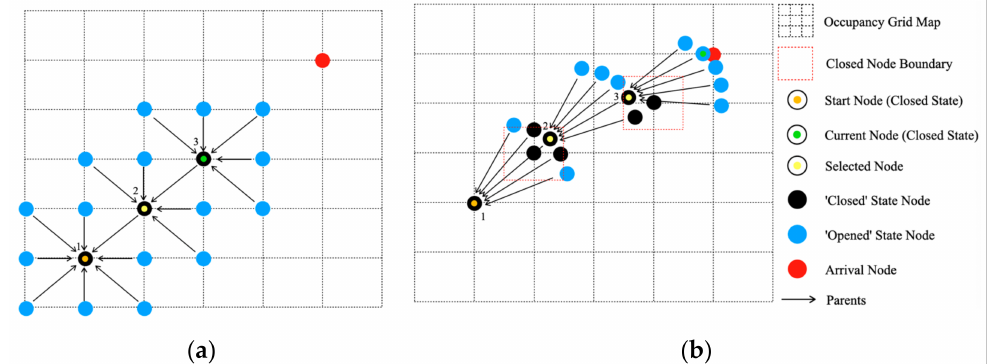
Figure 3. A comparison between regular A* and hybrid A*; ( a ) description of the A*’s node prolifera- tion and ( b ) description of Hybrid A*’s node